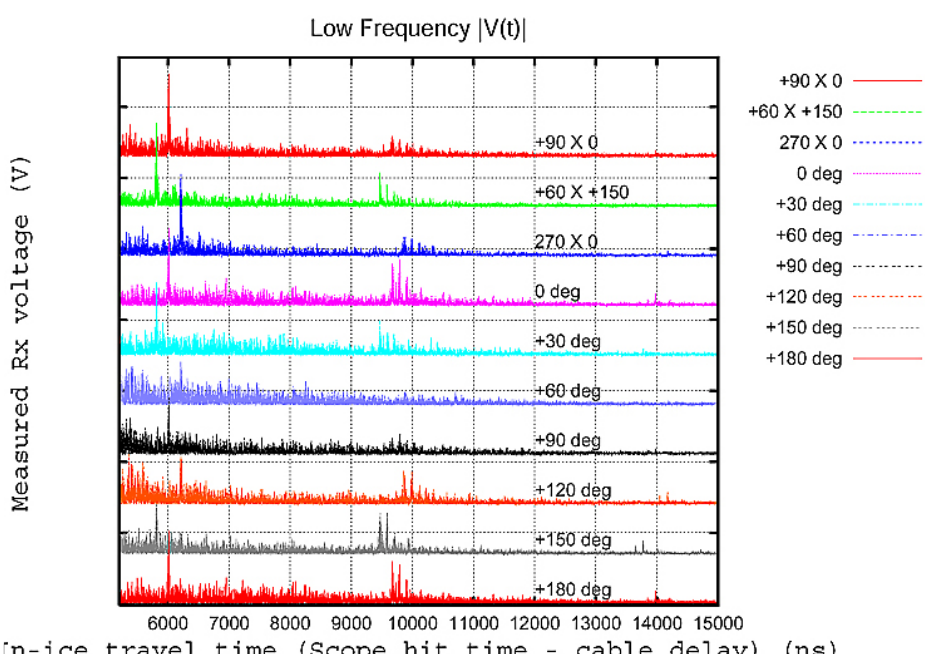
Fig. 10. Voltage magnitude after applying a 500MHz low-pass filter to the data shown in Fig. 3. Vertical divisions correspond to 5mV.